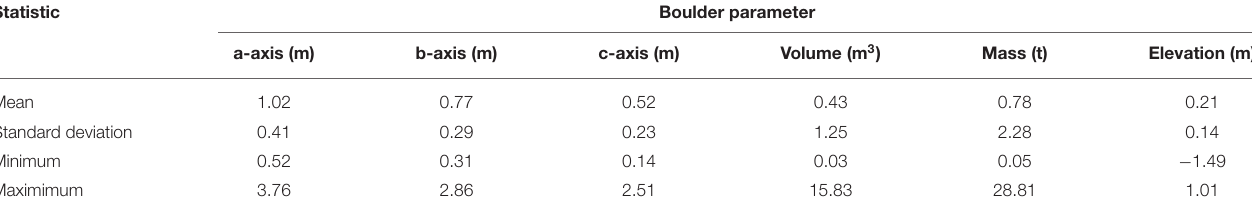
TABLE 3 | Summary measurements for coastal carbonate boulders on Xiaodonghai (XDH); n = 1,247. Statistic Boulder